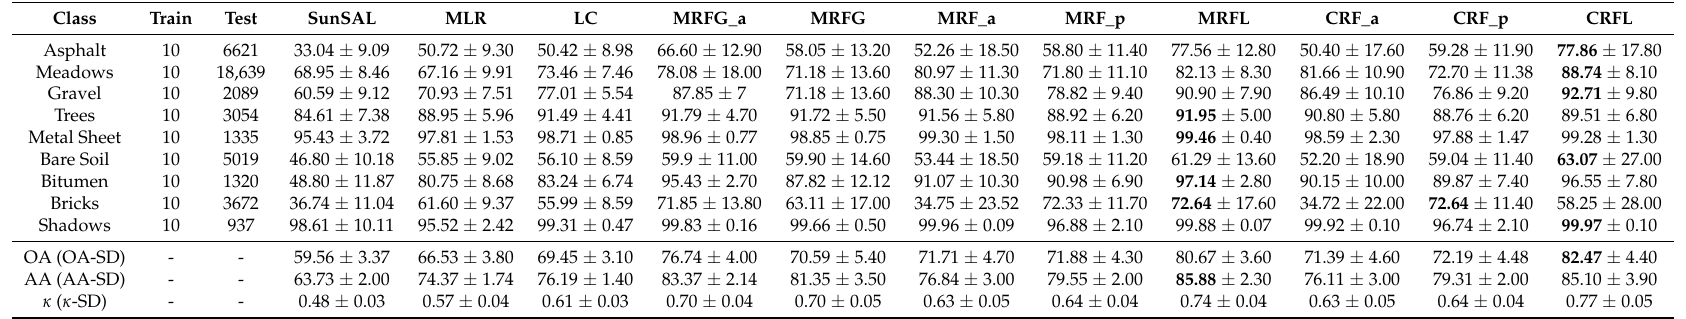
Table 2. Classification accuracies [%] with their standard deviations for the University of Pavia image (the highest accuracies are denoted in bold).